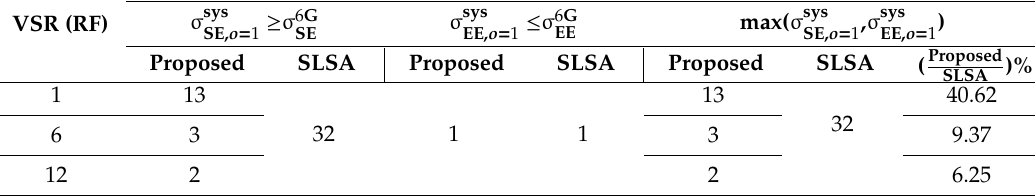
Table 3. Required HSR of the countrywide 28 GHz mmWave spectrum in L with a variation in VSR of the spectrum per building of small cells of MNO 1 in RF to satisfy average SE and EE requirements for 6G mobile